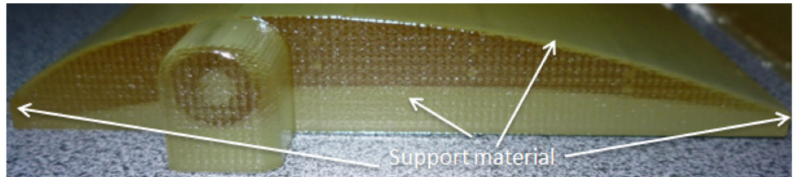
Figure 7. Specimen printed in matte finishing surrounded of support